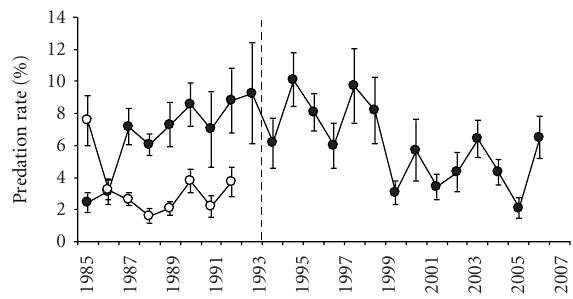
Figure 5: Predation rates of black grouse chicks by common buzzards ( ◦ ) and goshawks ( • ) in South Ostrobothnia and Oulu area. Dots denote means and bars 95% confidence limits for randomised predation rate values. Time series of the two study areas are separated by dotted line.